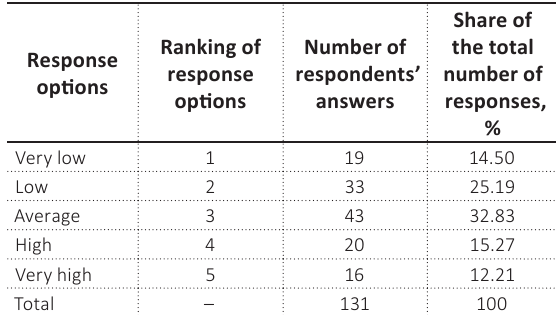
Table 5. Results of the survey “How do you assess the dynamics of innovation growth in your business?”